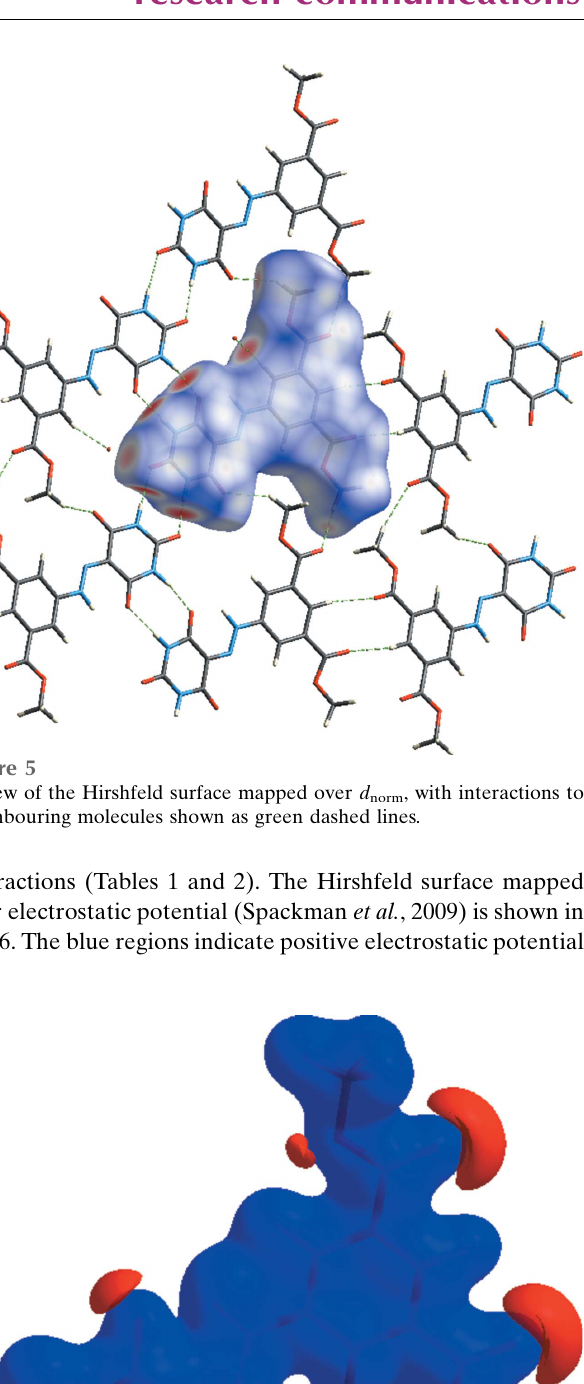
Figure 6 The Hirshfeld surface of the title compound plotted over electrostatic potential energy in the range from (cid:5) 0.0500 to 0.0500 a.u. using the STO- 3G basis set at the Hartree–Fock level of theory. Hydrogen-bond donors and acceptors are shown as blue and red regions around the atoms, corresponding to positive and negative potentials,